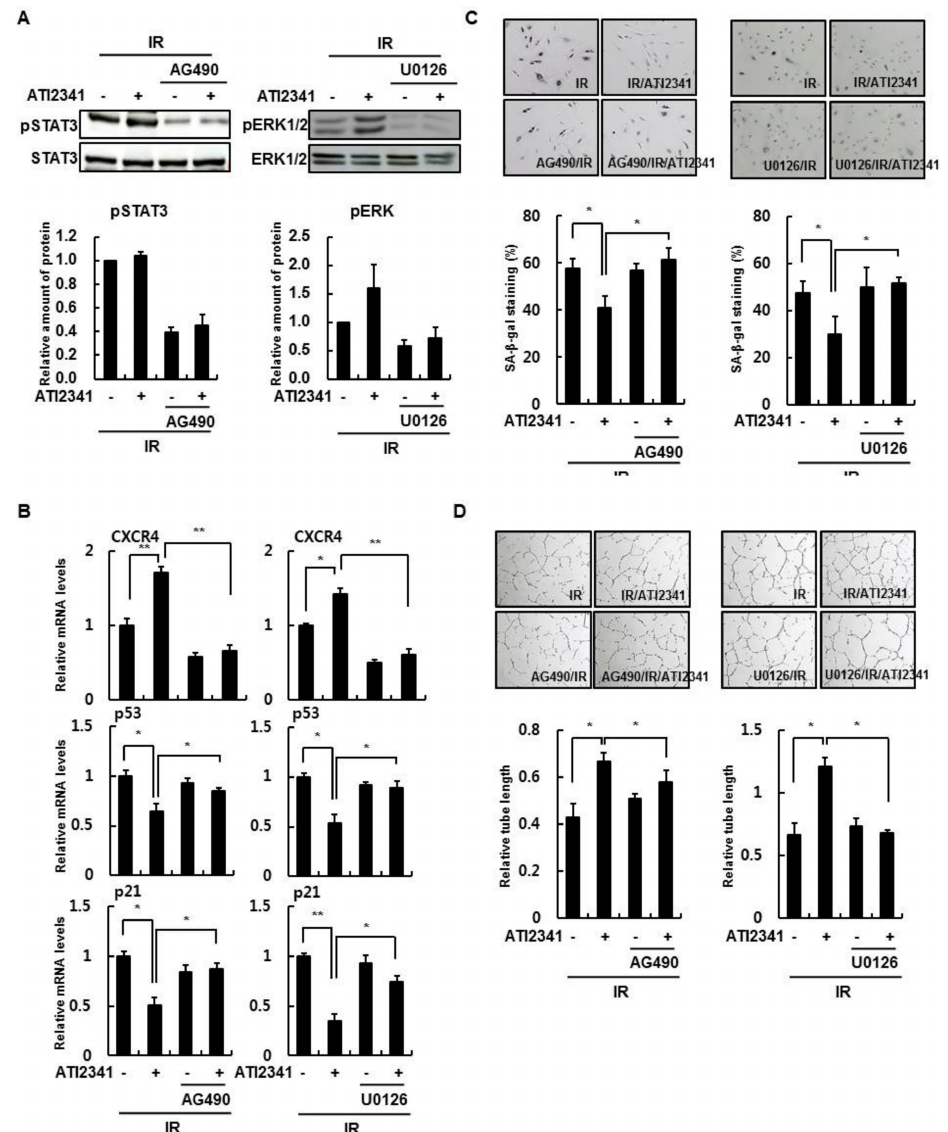
Figure 6. Phosphorylation of STAT3 and ERK regulates CXCR4 action. ( A ) HBMVECs were treated with 1 µ M / mL AG490, a STAT3 inhibitor, or 1 µ M / mL U0126, an ERK inhibitor. The cells were pretreated 1 µ g / mL ATI2341, a CXCR4 agonist, 1 h before irradiation (4 Gy) and incubated for 24 h. Protein levels were confirmed by Western blot analysis. ( B ) Gene expression was measured by real-time polymerase chain reaction analysis. ( C ) After irradiation (4 Gy), cells were cultured for 4 days, and SA- β -gal positive cells were counted by SA- β -gal staining ( × 100). ( D ) Tube formation experiments